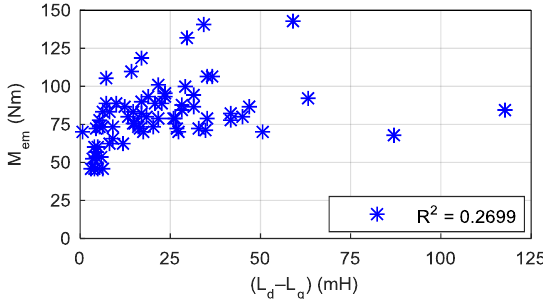
Figure 9. Mean electromagnetic torque ( M em ) versus the difference between direct and quadrature inductances ( L d − L q ).